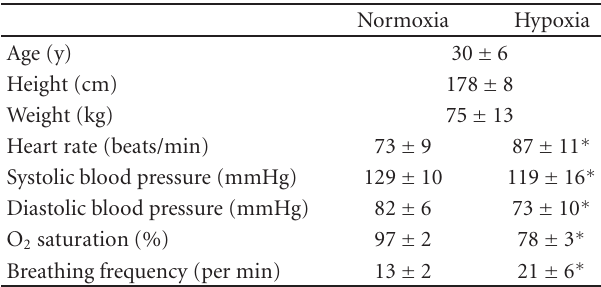
Table 1: Subject characteristics at baseline and under hypoxia equivalent to a height of 5500m for 2